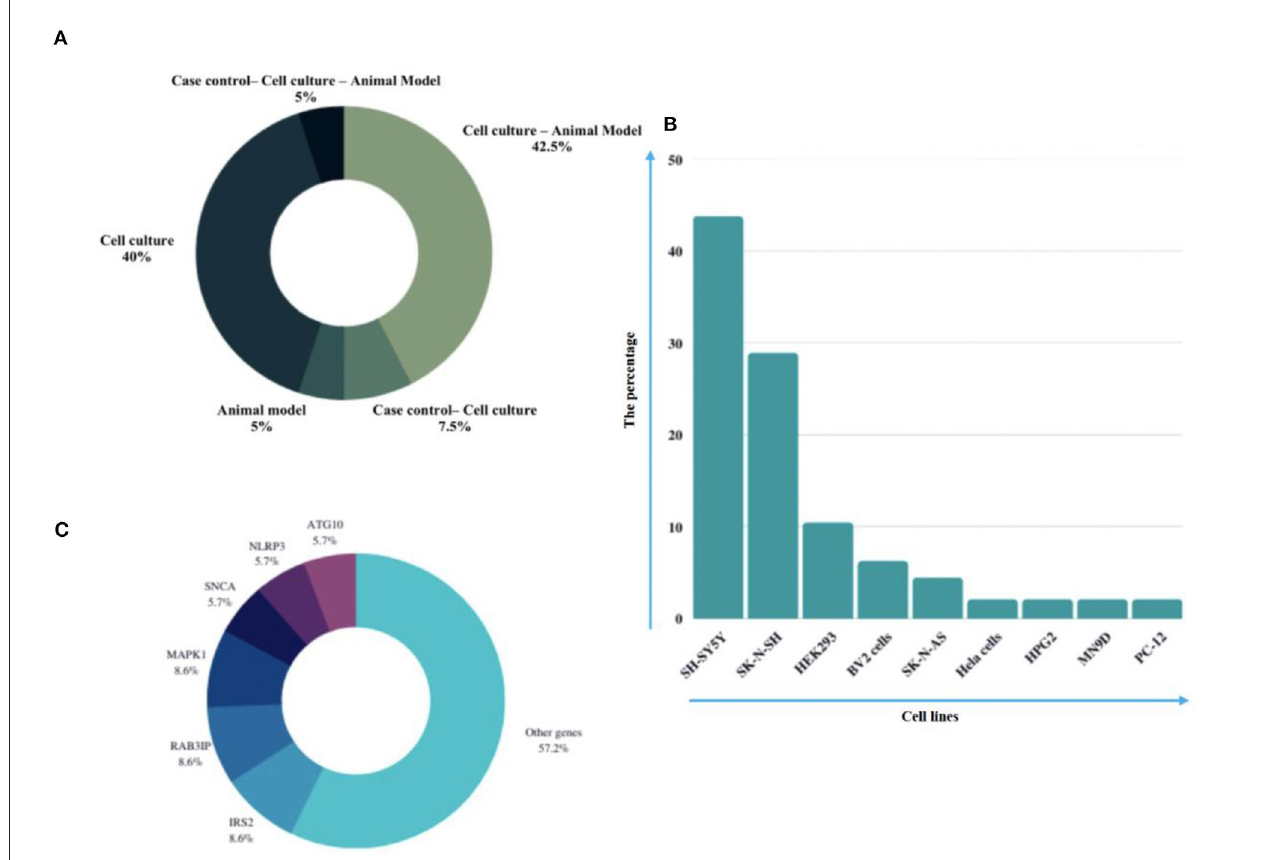
FIGURE2 A summary of the qualified studies’ details. (A) The design of studies. The majority of studies utilized cell culture and animal models (42.5%), and 40% of studies only utilized cell culture in their study design. (B) Percentage of cell lines utilized in the studies. SH-SY5Y (43.75%), SK-N-SH (22.88%), and HEK293 (10.48%) were the most used cell lines in the studies. (C) Percentage of targeted genes involved in ceRNA axes in PD. RAB3IP, SP1, and IRS2 were among the most targeted genes studied in PD’s ceRNA axes. However, most of the axes involved novel genes, as provided by the other genes in the